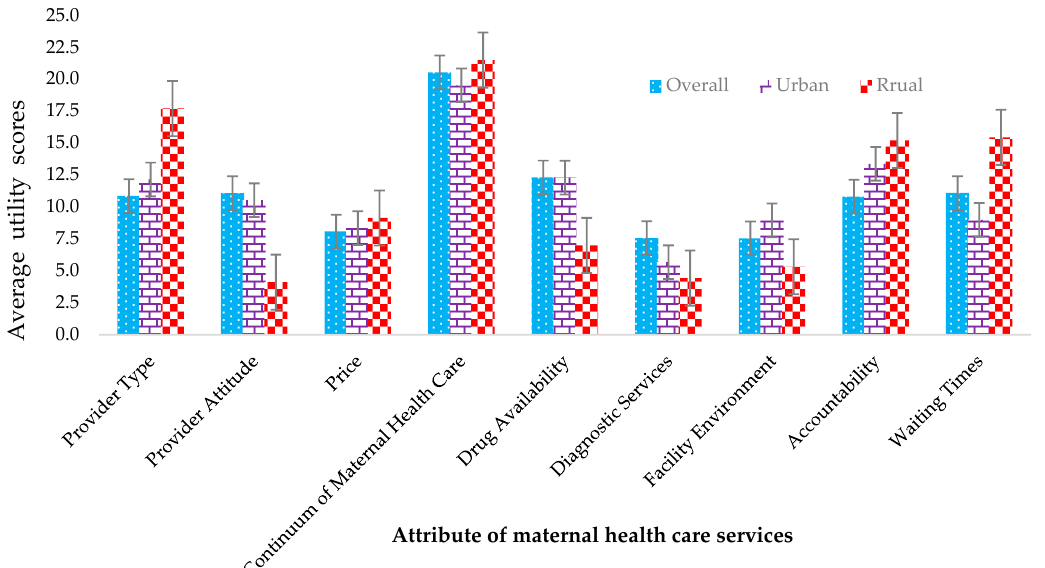
Figure 4. The distribution of discrete choice experiment (DCE) attribute rankings among the rural and urban participants.